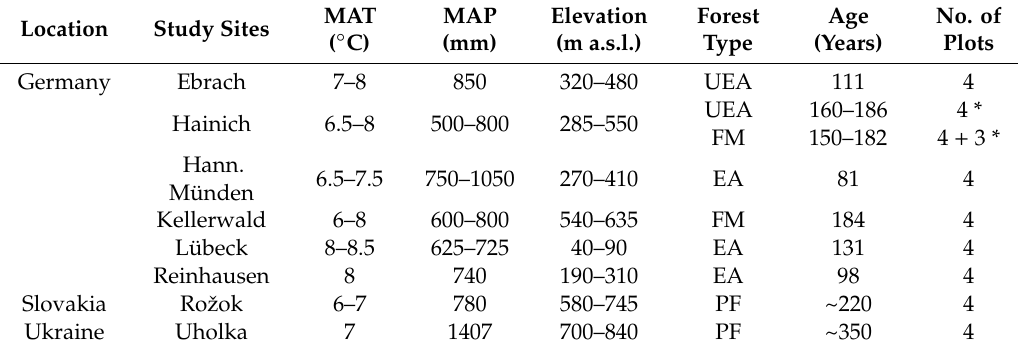
Table 1. Information on the basic environmental conditions of the study sites (MAT = mean annual temperature; MAP = mean annual precipitation). For each study site, we chose four study plots. For the Hainich-Dün region, we considered additional study plots (*), which were part of the Biodiversity Exploratories. Number (No.) of study plots for each forest type were: even-aged (EA): n = 12, uneven-aged (UEA): n = 8, formerly managed (FM): n = 11 and primary forest (PF): n = 8. Location Study Sites